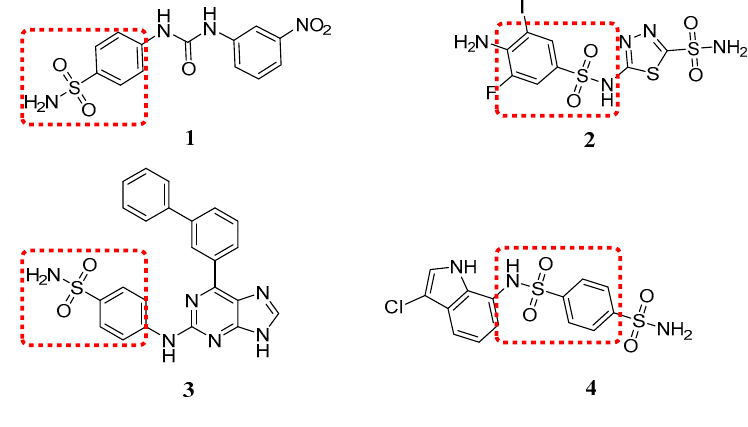
Figure 2. Antitumor sulfanilamides.